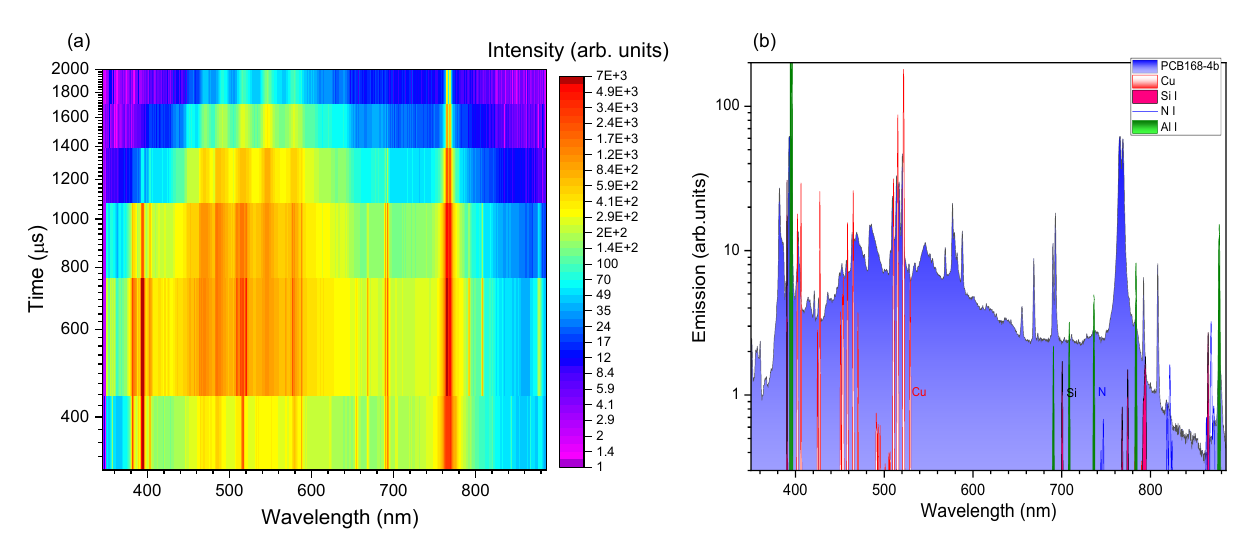
Figure 2. ( a ) Temporal evolution of emission inducedby electrical breakdown of a silicon bridge with BKNO 3 on the PCB substrate. The integration time was 100 µs with a sampling interval of 312 µs. The intensity and time are presented in log-scale. ( b ) Spectra at time slice t = 623 µs overlaid with atomic emission lines of Cu I, Si I, N I Al I (data from NIST database for light breakdown spectroscopy LIBS; I indicates atomic spectra, and II indicates single ionisation spectra). Each intensity plot has different counts and is presented for better visualisation of the overlap of peaks.